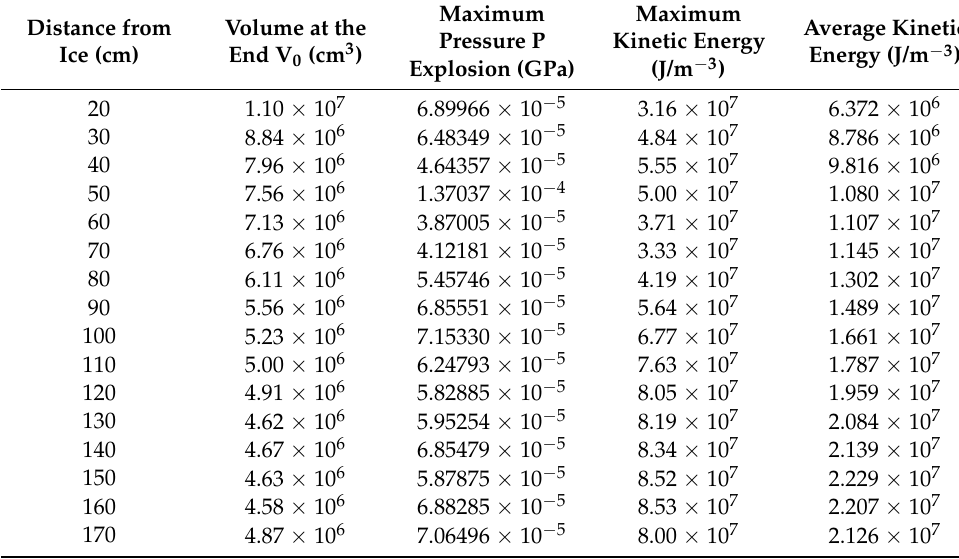
Table 7. Relationship between explosive ice distance and ice blasting volume, maximum pressure at the end, instantaneous kinetic energy, and average kinetic